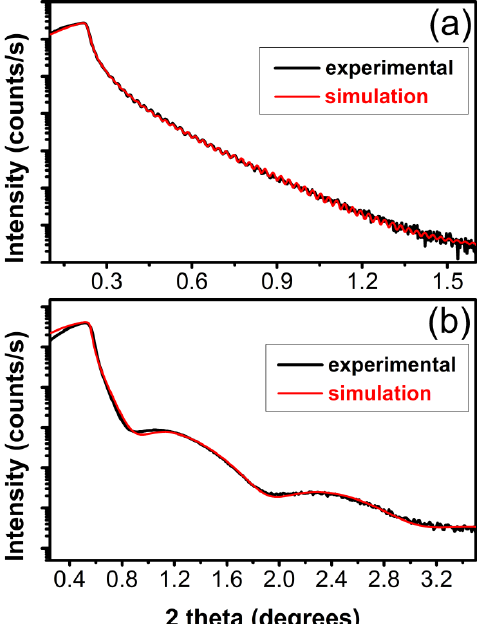
Figure 3. Typical X-ray reflectivity (XRR) patterns (red line) and the best fit (black line) of carbon films obtained in ( a ) vacuum and ( b ) 10 mbar CH 4 at 200 °C on bare Si (100)